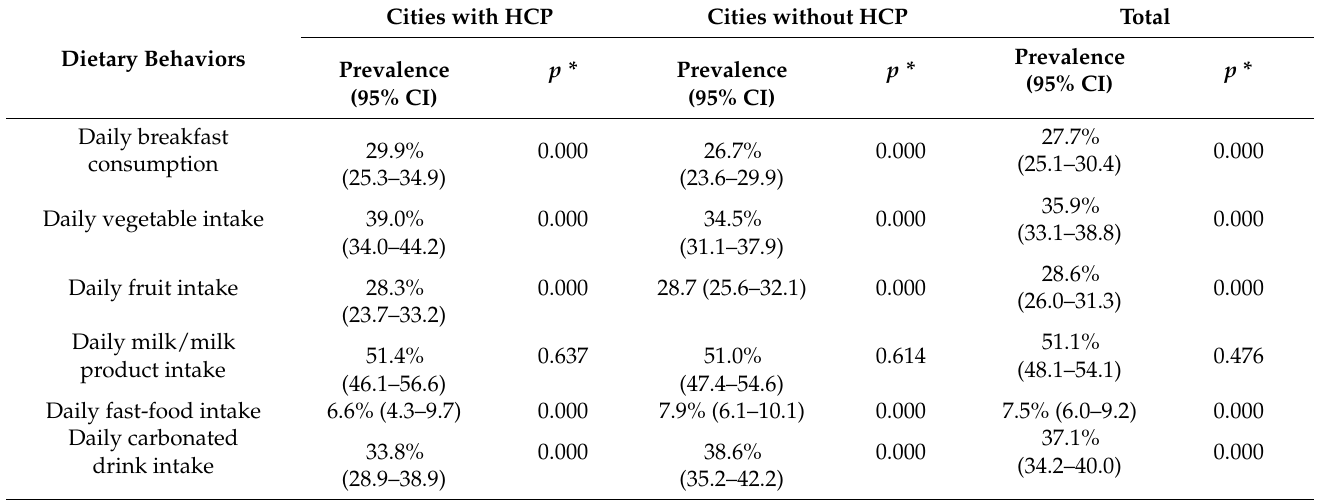
Table 2. Dietary behaviors of adolescents in Qassim, Saudi